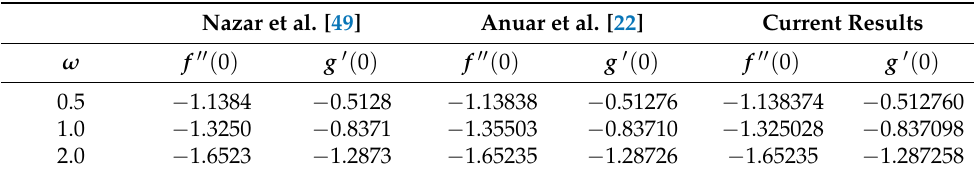
Table 3. The comparison results of rotation parameter ω at different values when φ 1 = φ 2 = 0, λ = 1, S = 0, M = Rd = Ec = 0, and Pr = 6.2. Nazar et al. [49] Anuar et al. [22] Current Results